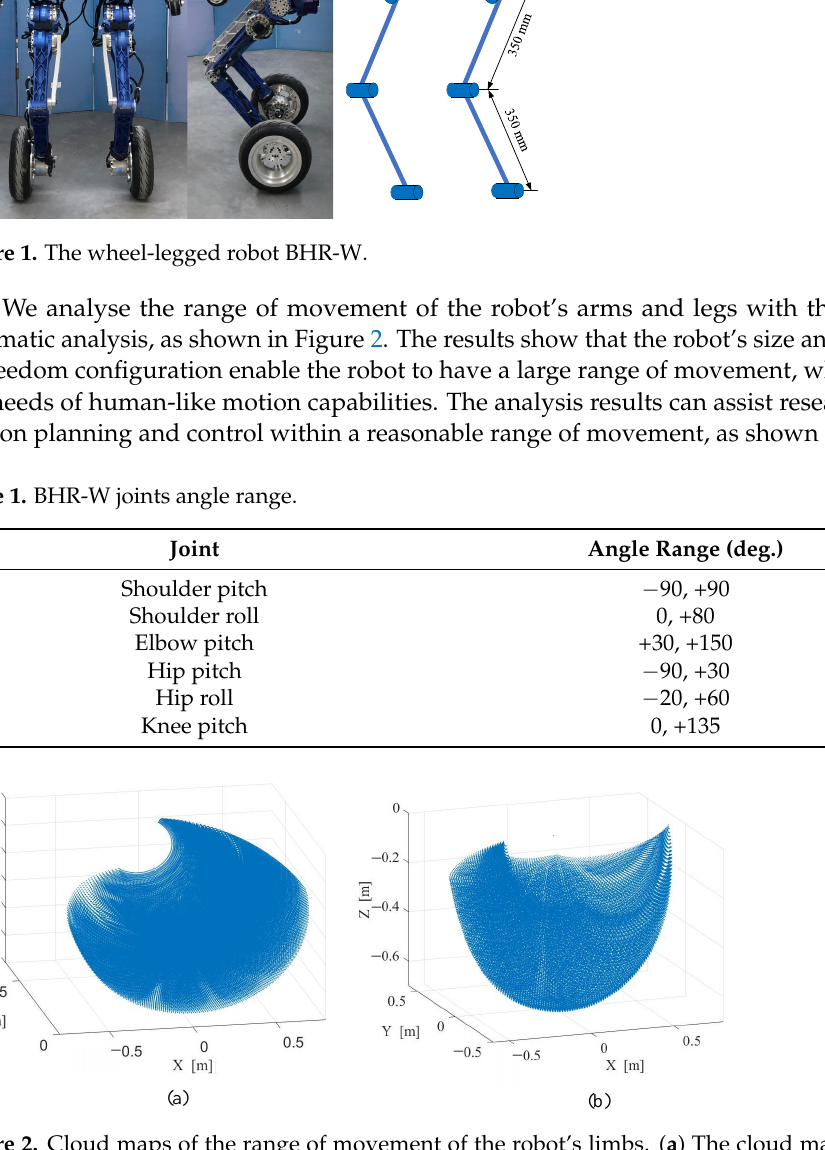
Figure 2. Cloud maps of the range of movement of the robot’s limbs. ( a ) The cloud map of arms; ( b ) The cloud map of